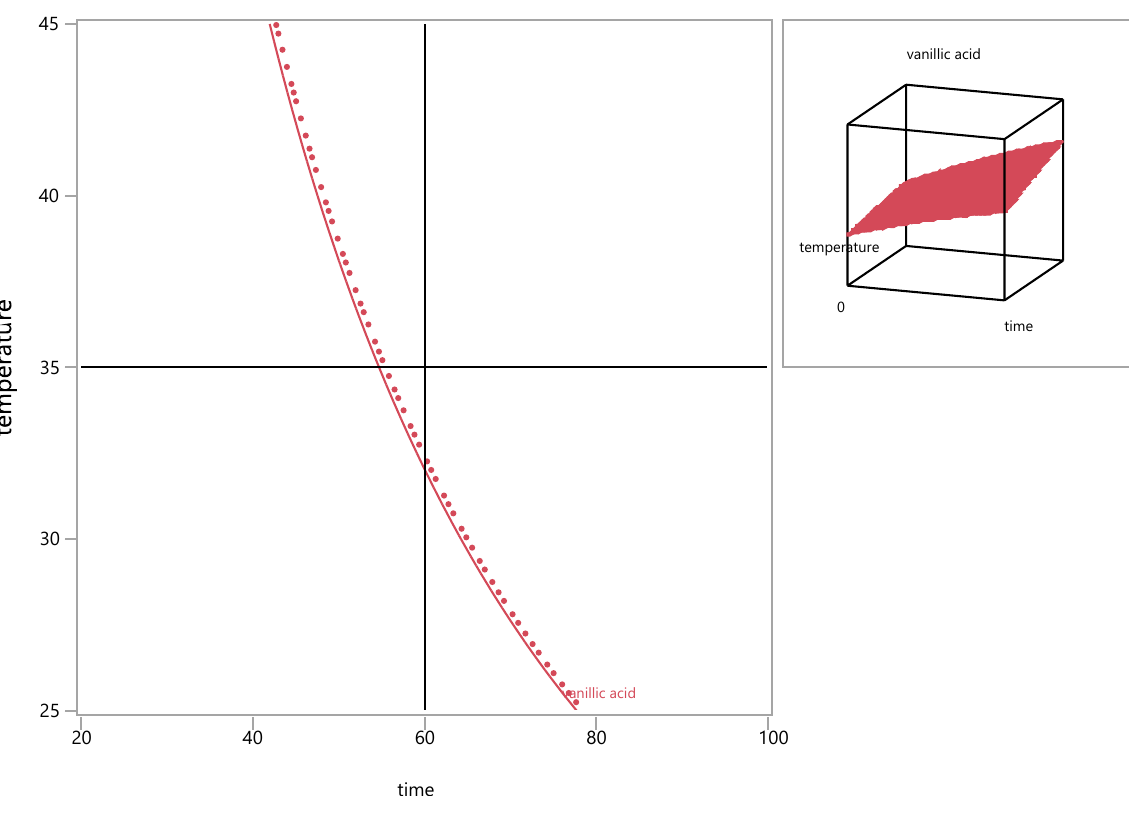
Figure 2: Contour profiler of the extraction process of vanillic acid depending on temperature and time with the concentration of ethanol 40% and solmodul: